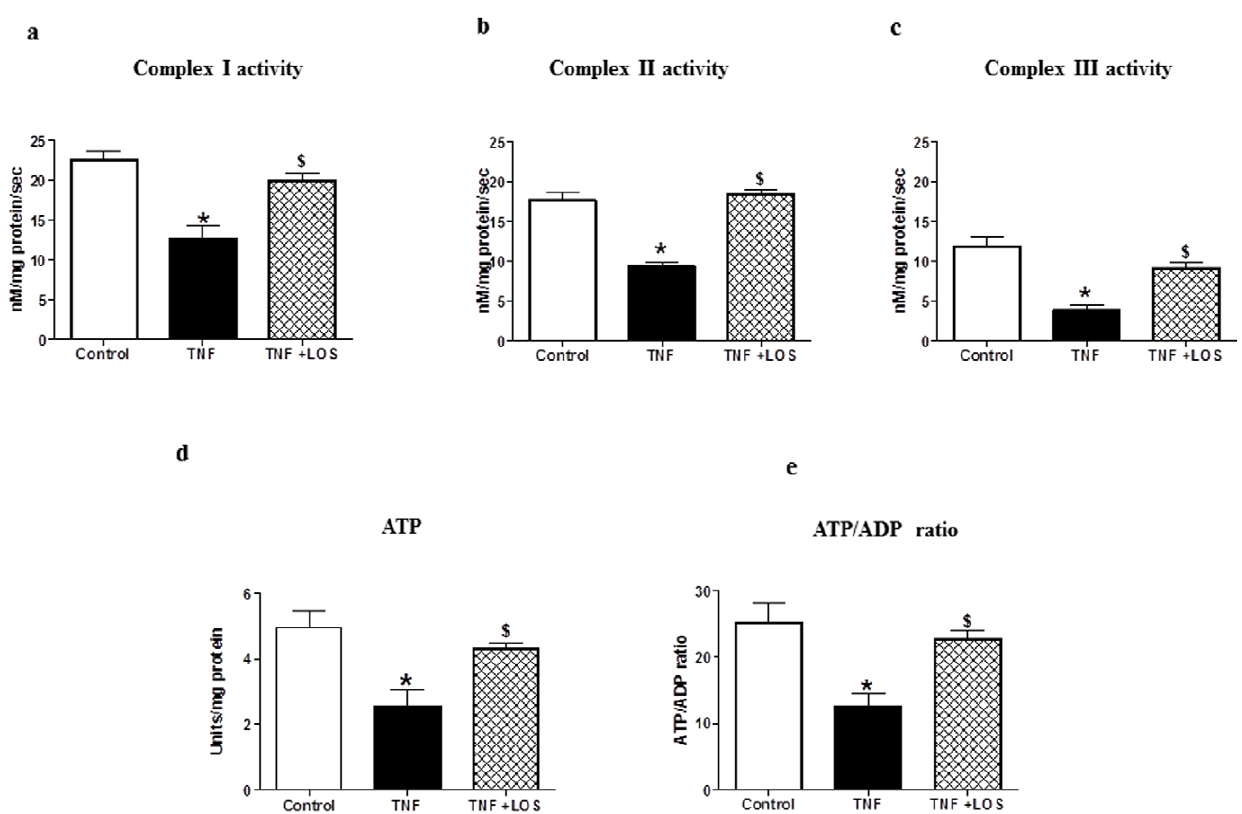
Figure 6. Effect of TNF on expression of mitochondrial respiratory complexes I, II and III measured by EPR spectroscopy. The activities of mitochondrial respiratory a) complex I, b) complex II, and c) complex III were assessed using EPR spectroscopy. TNF decreased the activities of all three complexes in isolated heart mitochondria; these results indicate a derangement in electron transport chain activity. Losartan attenuated these changes. * p , 0.05 vs. control; $ p , 0.05 vs. TNF d) ATP production rates and e) ATP/ADP ratios of heart mitochondria from each experimental group. TNF administration resulted in significant decreases in both ATP production rate and ATP/ADP ratio, which is suggestive of electron transport chain dysfunction. Losartan attenuated the changes seen in ATP production and ATP/ADP ratio. * p , 0.05 vs. control; $ p , 0.05 vs.TNF.